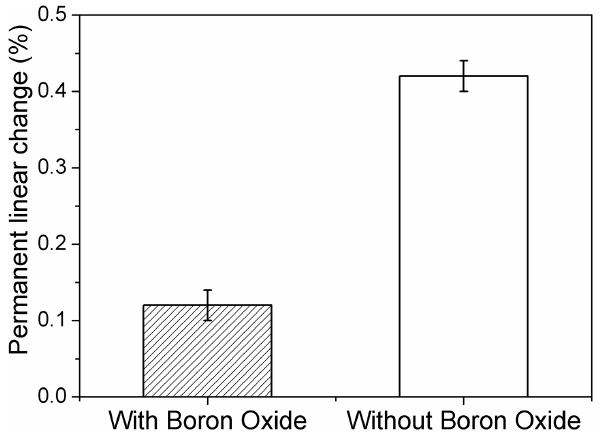
Figure 2: Permanent linear changes of castables after firing at 1450°C.